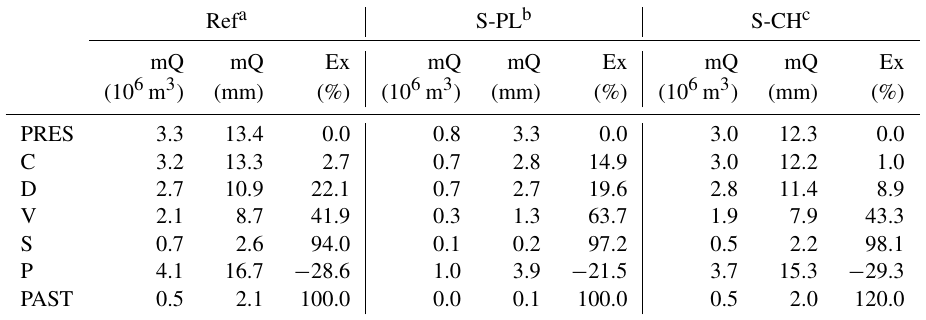
Figure 8. Mean discharge (mQ) for present and past reference cases and for the attribution simulations described in Table 5, with either independent or combined factors. For the reference cases, observation data are added (red points). Errors bars indicate the standard deviation of the 10 members and the 15 years of simulation. Table 8. Mean annual discharge (mQ) and Ex values obtained for the initial simulation with default parameters presented in Fig. 8 (Ref a ) and the sensitivity test for plane (S-PL b ) and channel (S-CH c )